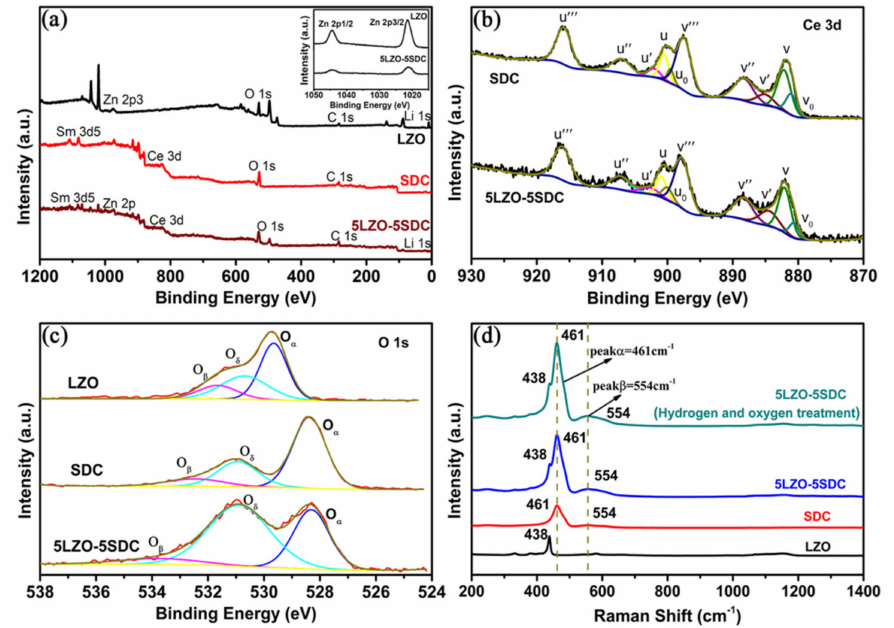
Figure 9. XPS results for the LZO, SDC, and 5LZO-5SDC samples: ( a ) survey spectra (inset: Zn 2p3/2 and Zn 2p1/2 peaks), ( b ) Ce 3d core-level spectra, and ( c ) O 1s core-level spectra; and ( d ) Raman spectra for LZO, SDC, 5LZO–5SDC, and the 5LZO-5SDC treated in hydrogen and oxygen at 550 ◦